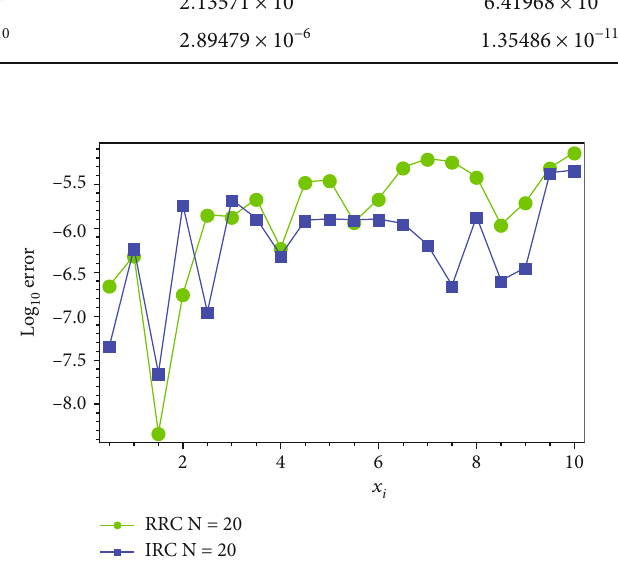
Figure 1: The absolute errors for the proposed two schemes when N = 20 with λ = 1 Table 6: Comparing the CPU time used for RRC and IRC schemes.